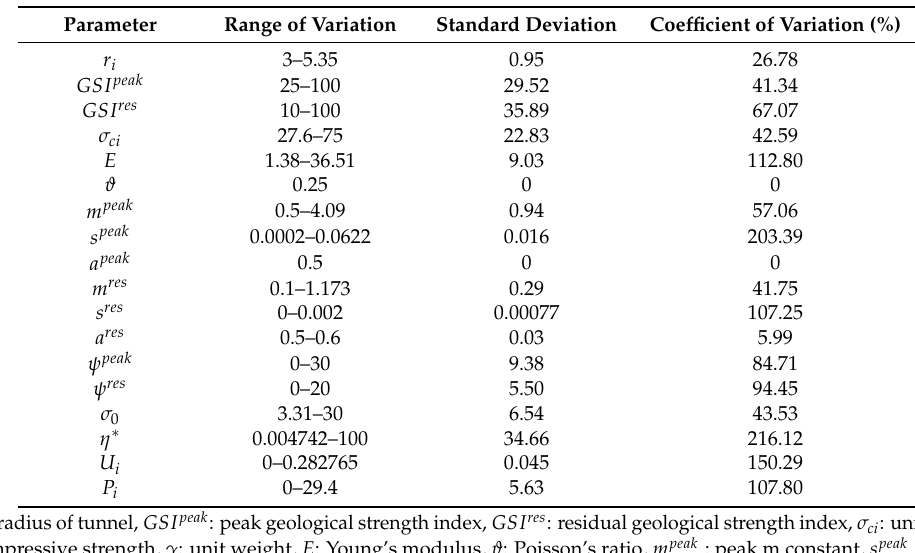
Table 2. Input and output parameters and their range of variation used in the prediction of the P i (Hoek–Brown